Question: Summarize what this figure shows in one sentence.
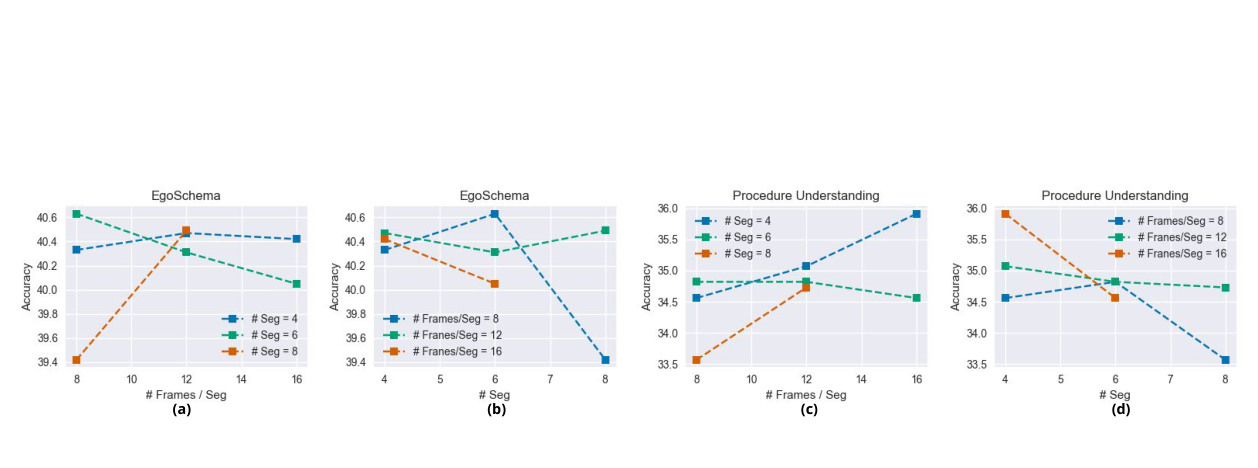
Answer: Ablation over number of segments and frames. Increasing the number of frames per segment while using a smaller number of segments during training is generally beneficial for long video understanding. We note that we run into an out-of-memory error with 8 segments of 16 frames each.